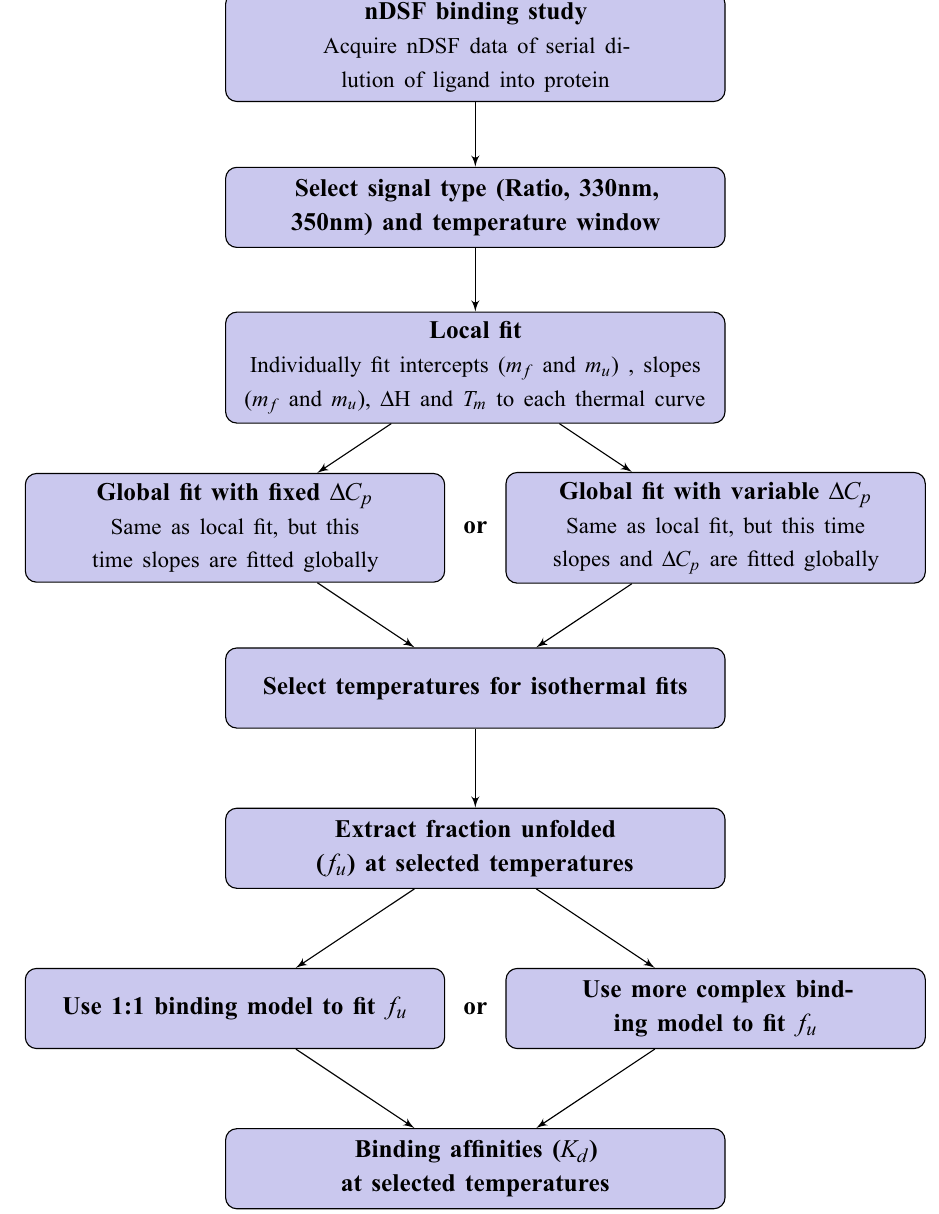
Figure 1. Flow chart of isothermal analysis of nDSF binding study. After selecting the signal type ( F 330 , F 350 or Ratio) and the spectral window, a local fit of the thermal curves yields starting values for the subsequent global fit. This can be either done with a fixed ∆ C p or with ∆ C p as fitted variable. The latter option is still an experimental feature. The next step is the calculation of the fraction unfolded f u for selected